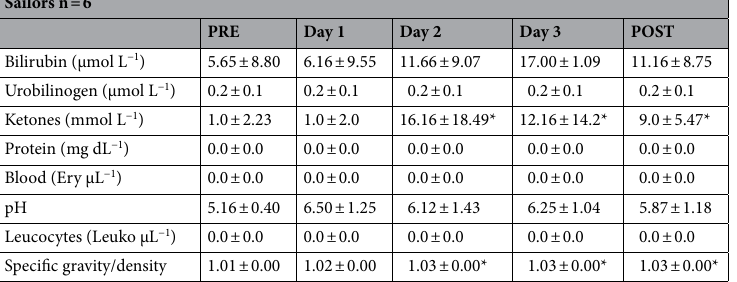
Table 4. Urine standard analysis . Mean (± SD) values of the investigated variables in the urine test strip in the sailors. Changes in urine standard urinalysis referred to PRE are shown. Statistically significant difference at p < 0.05 (* symbol).